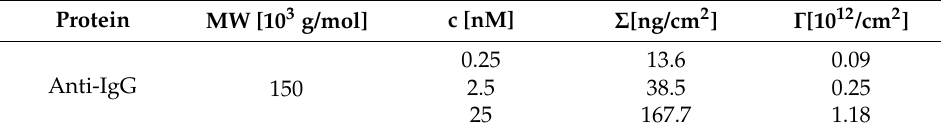
Table 1. Experimental Anti ‐ IgG concentrations, surface mass coverages and surface densities.